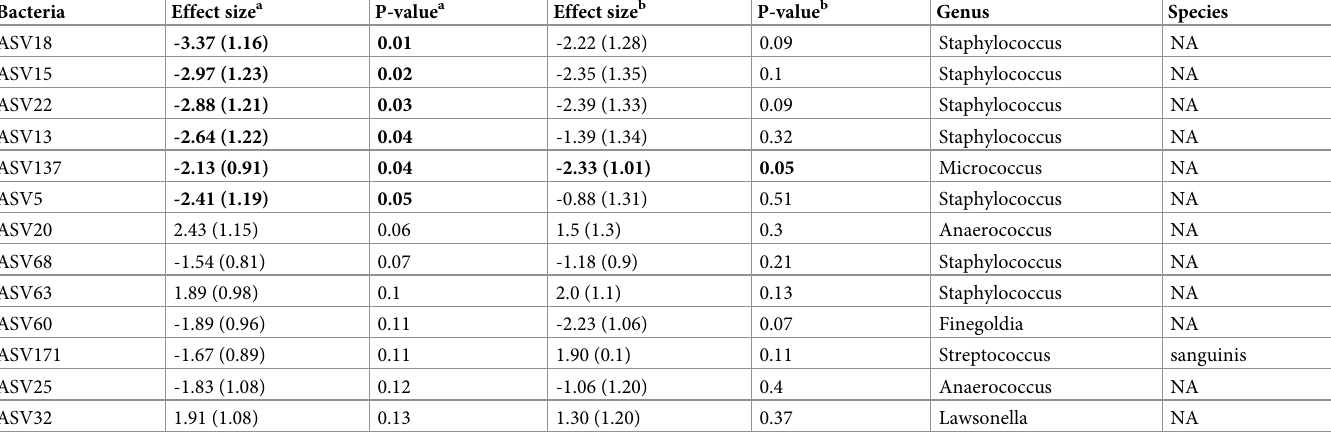
Table 2. Association analysis between ASV composition (ASV individual level) and seborrheic dermatitis (with categories controls, non-lesional cases and lesional cases).